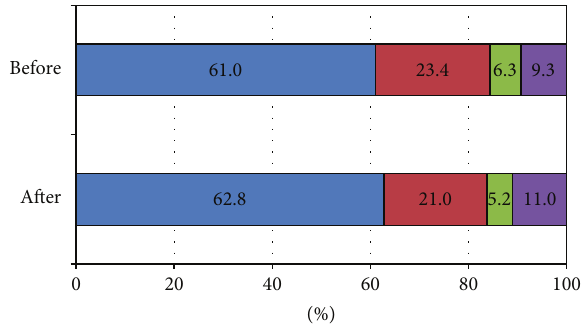
Figure 1: Prevalence of diabetes before and after the Great East JapanEarthquake.Subjectswereclassifiedashavingnormalglucose, normal-high glucose, borderline glucose, or diabetes, in accordance with the Japan Diabetes Society (JDS) guidelines. Purple color: diabetes was defined as a fasting plasma glucose level ≥ 126 mg/dL (7.0mmol/L), an HbA1c level ≥ 6.5%, or the self-reported use of anti- hyperglycemic agents. Green color: borderline glucose was defined as a fasting plasma glucose level ≥ 110mg/dL (6.1mmol/L), an HbA1c level ≥ 6.0% with a fasting plasma glucose level < 126 mg/dL (7.0mmol/L), or an HbA1c level < 6.5%. Red color: normal-high glucose was defined as a fasting plasma glucose level ≥ 100 mg/dL (5.5 mmol/L), an HbA1c level ≥ 5.6% with a fasting plasma glucose level < 110mg/dL (6.1mmol/L), or an HbA1c level < 6.0%. Blue: normal glucose was defined as a fasting plasma glucose level < 100mg/dL (5.5mmol/L) with an HbA1c level < 5.6%.